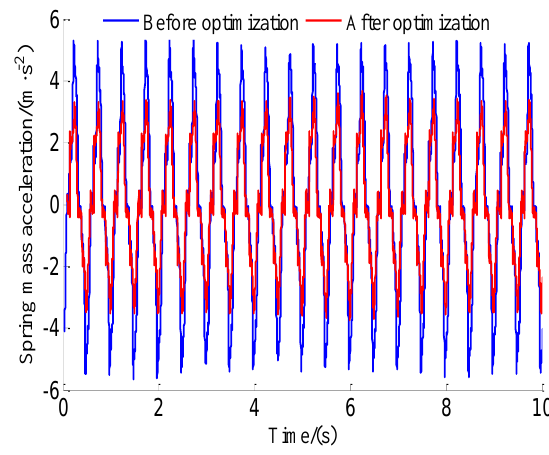
Figure 13. Test chart of spring mass acceleration response.